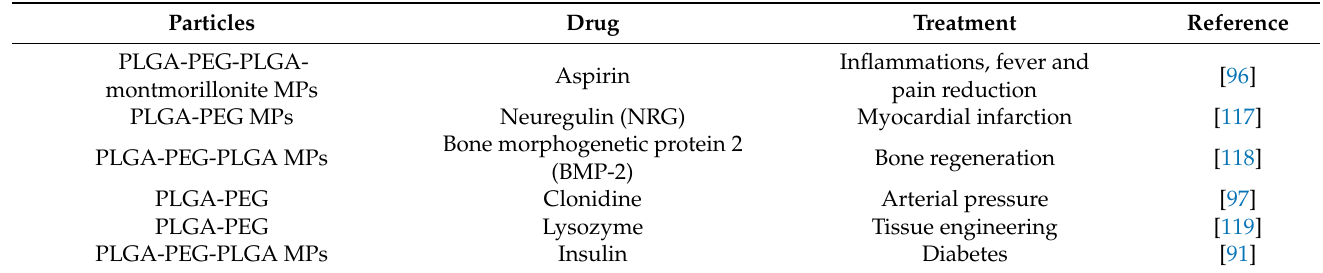
Table 4. Microparticles from PLGA-PEG copolymers for controlled drug